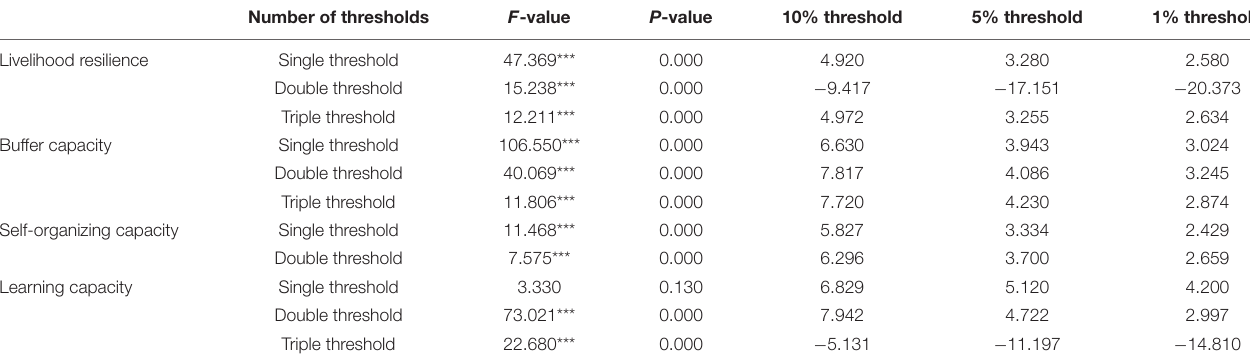
TABLE 5 | Threshold effect test.